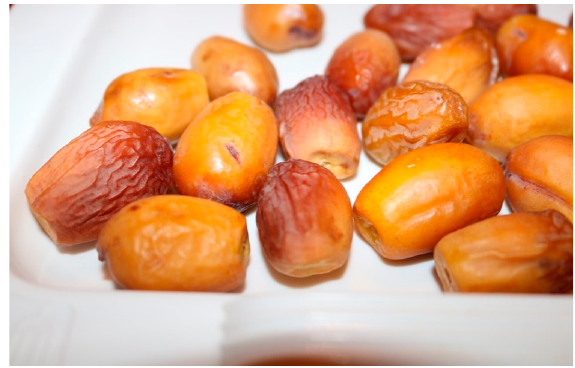
Figure 25. Sample of SagaiIRAQ dates.